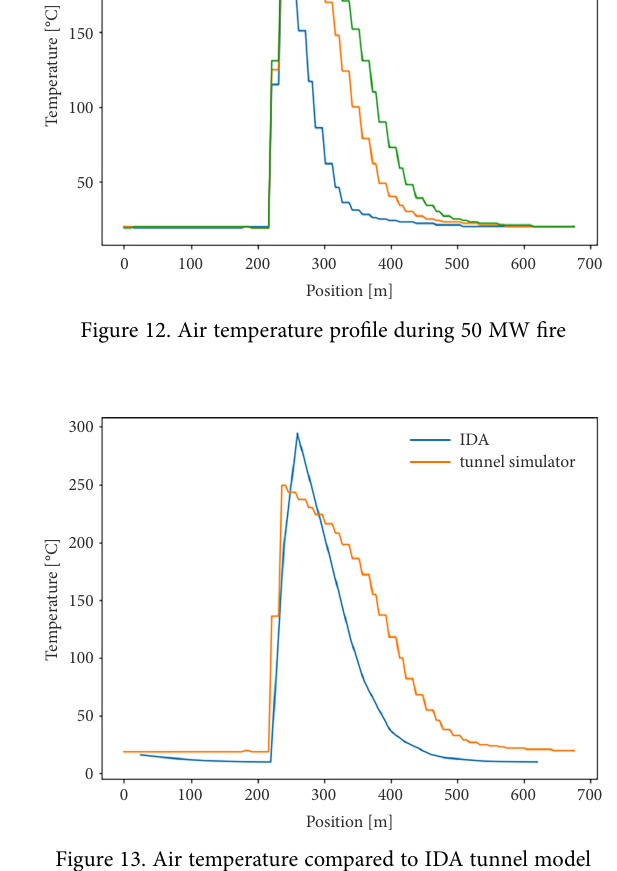
Figure 13. Air temperature compared to IDA tunnel model